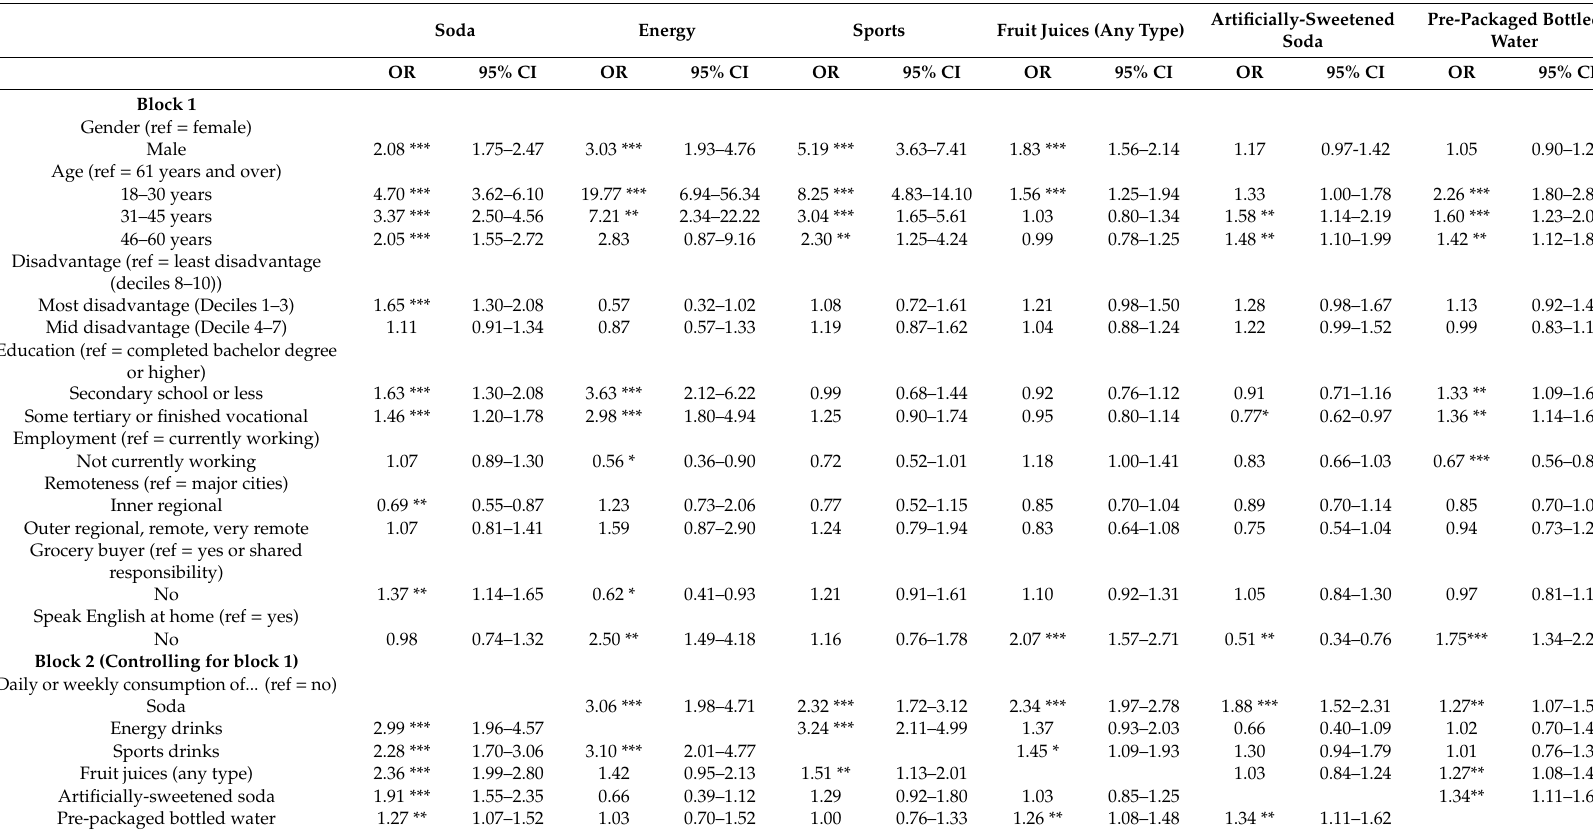
Table 3. Hierarchical logistic regression analyses examining demographic characteristics (block 1), other drink types (block 2), and current health, behavior,